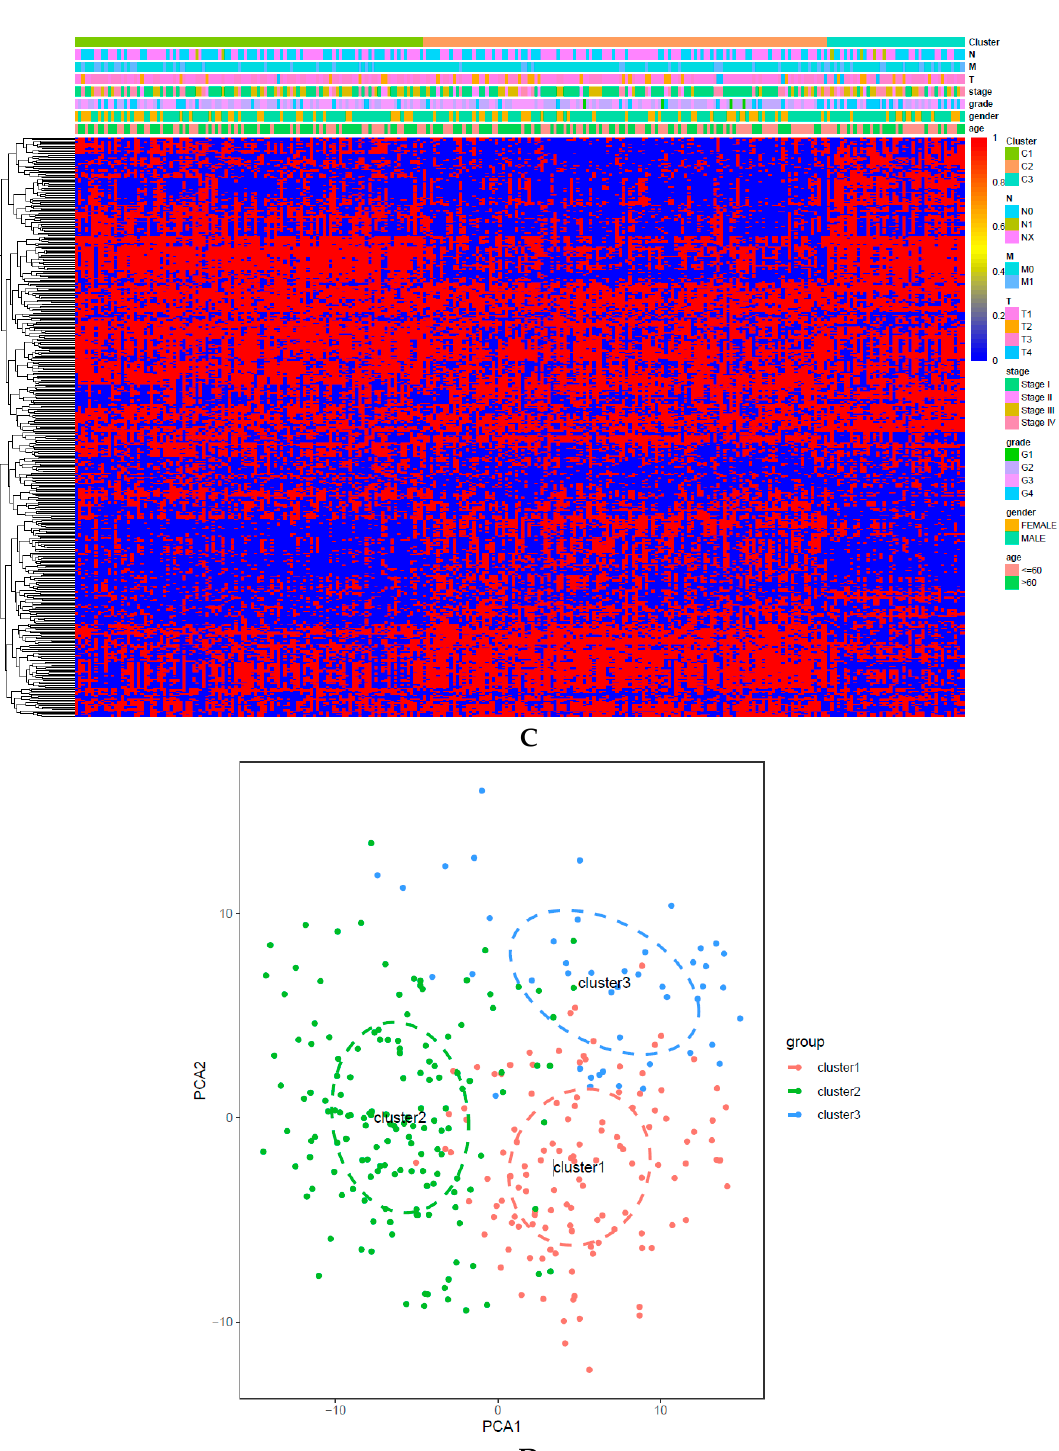
Figure 1. ( A ) Differentially methylated sites (DMSs) between normal samples and bladder cancer samples. ( B ) The consensus clustering of 441 CpGs-pairs was divided into three subgroups. ( C ) Heatmap of three clusters. ( D ) Principal component analysis (PCA) validated the stability of the classification.